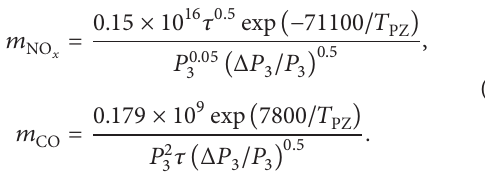
and cold) compared to the increased compressor